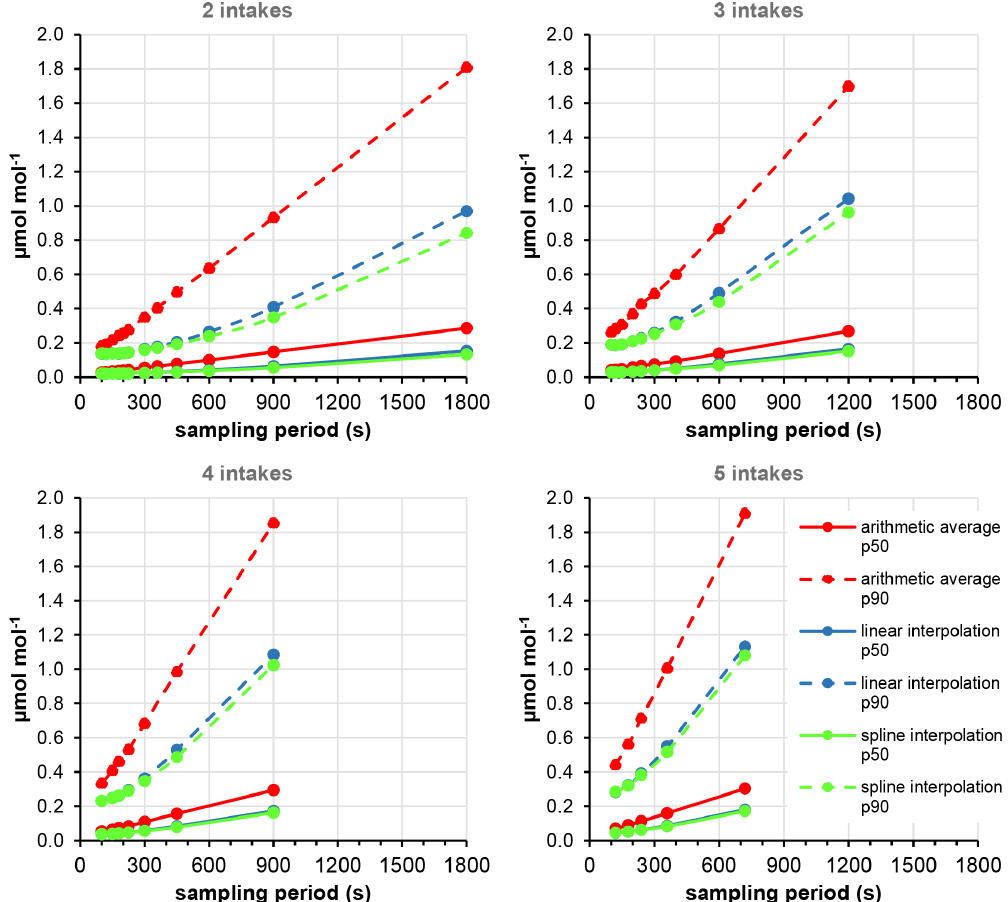
Figure 4. The median (p50) and the 90-percentile (p90) values of the absolute deviation from the true hourly average as a function of sampling time and number of intakes calculated from the fitted Cauchy